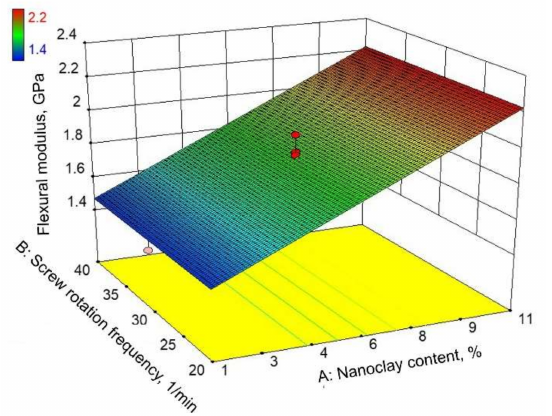
Figure 8. Response surface of reduced linear regression model: flexural modulus.